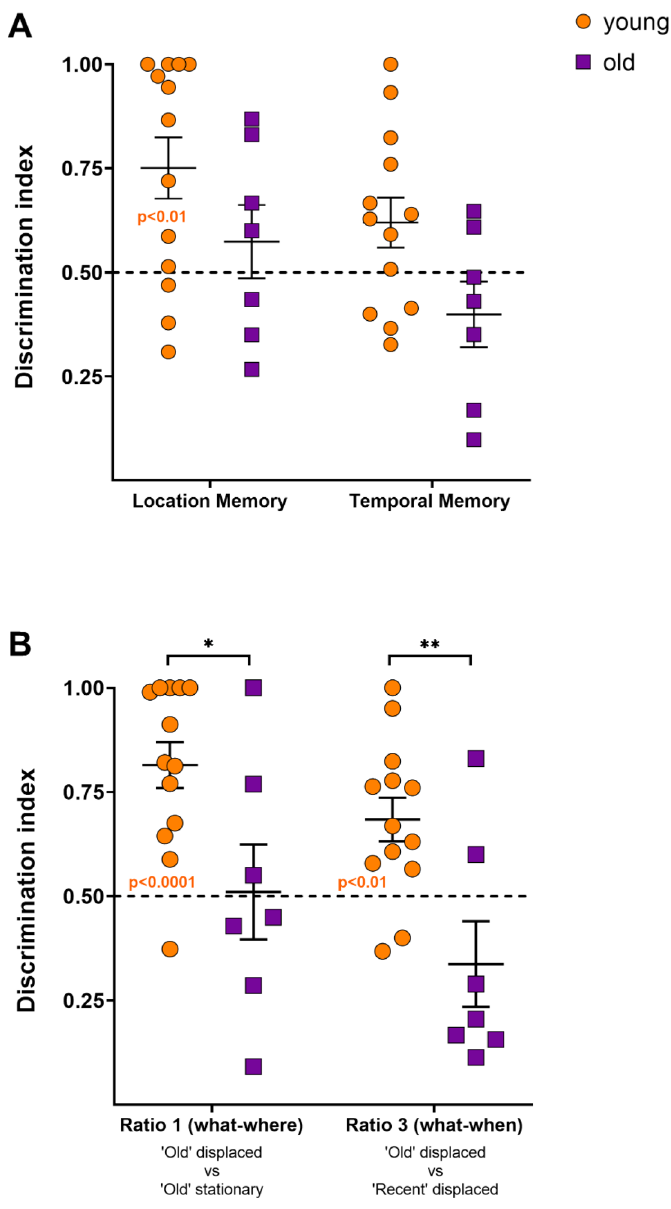
Figure 6. Discrimination indices related to the www-test obtained from the young and old group. ( A ) Location memory and temporal memory indices. ( B ) Discrimination indices related to the ‘old’ displaced object. Ratio 1 (‘old’ displaced vs. ‘old’ stationary), and ratio 3 (‘old’ displaced vs ‘recent’ displaced). Data are represented as means ± SEM ( * P < 0.05). All individual values are shown. Dotted lines represent the chance level. Orange significant P values represent the ratio discriminations from the young group above chance